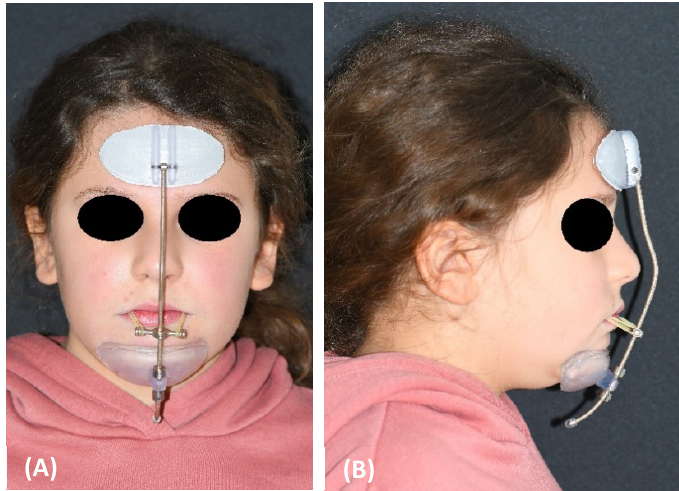
Figure 6. ( A , B ) The customized facemask in place.